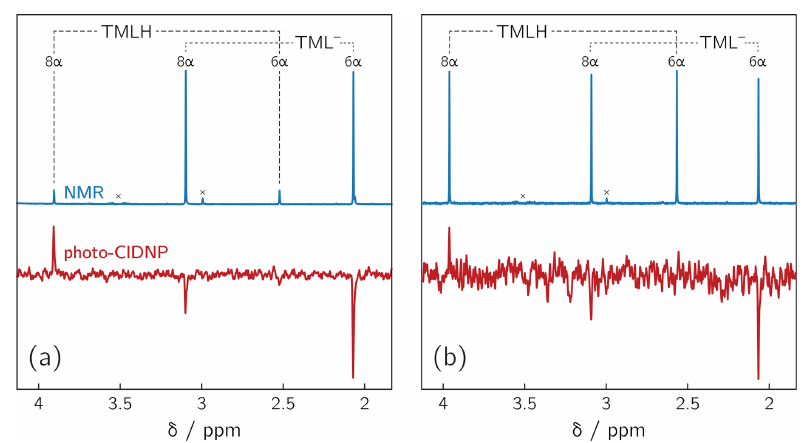
Figure 2. 1 H NMR and photo-CIDNP data of alkaline solutions of 6,7,8-trimethyllumazine: (a) TMLH:TML − ratio of 1:10; 6,7,8- trimethyllumazine concentration: 4mM; excitation wavelength: 425nm; (b) TMLH:TML − ratio of 1:1; 6,7,8-trimethyllumazine concen- tration: 4mM; excitation wavelength: 470nm. Signals marked with “ × ” arise from sample impurities.